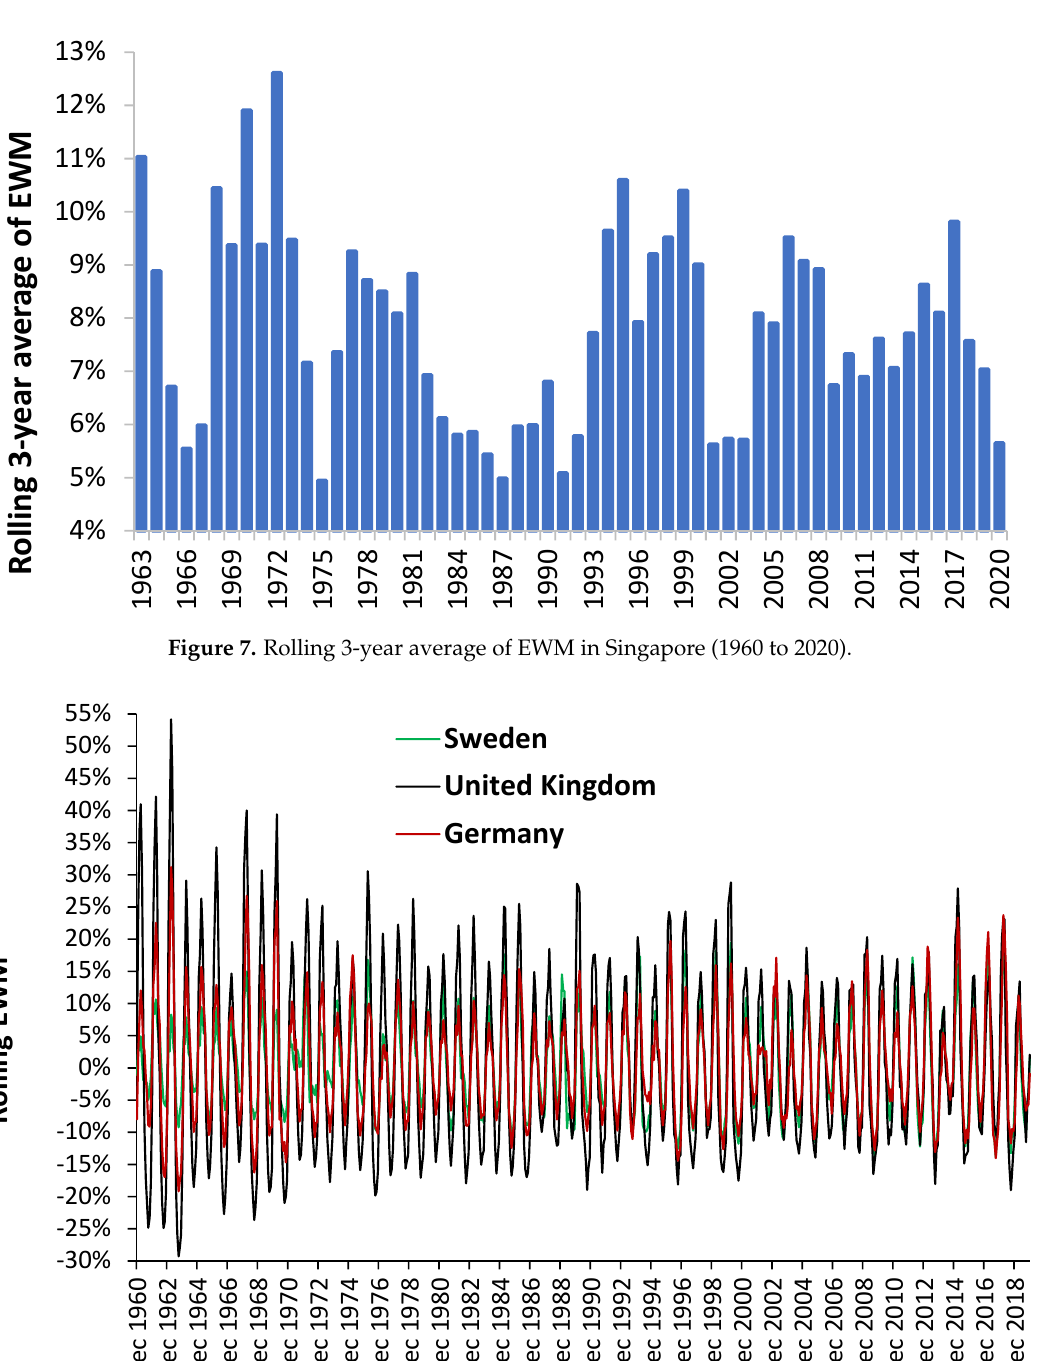
Figure 8. Rolling EWM in Sweden, Germany, and the United Kingdom (1960 to